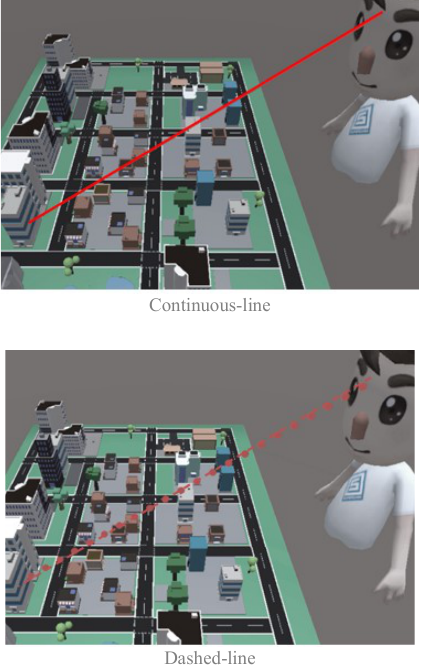
Figure 2. An illustration of two gaze-line